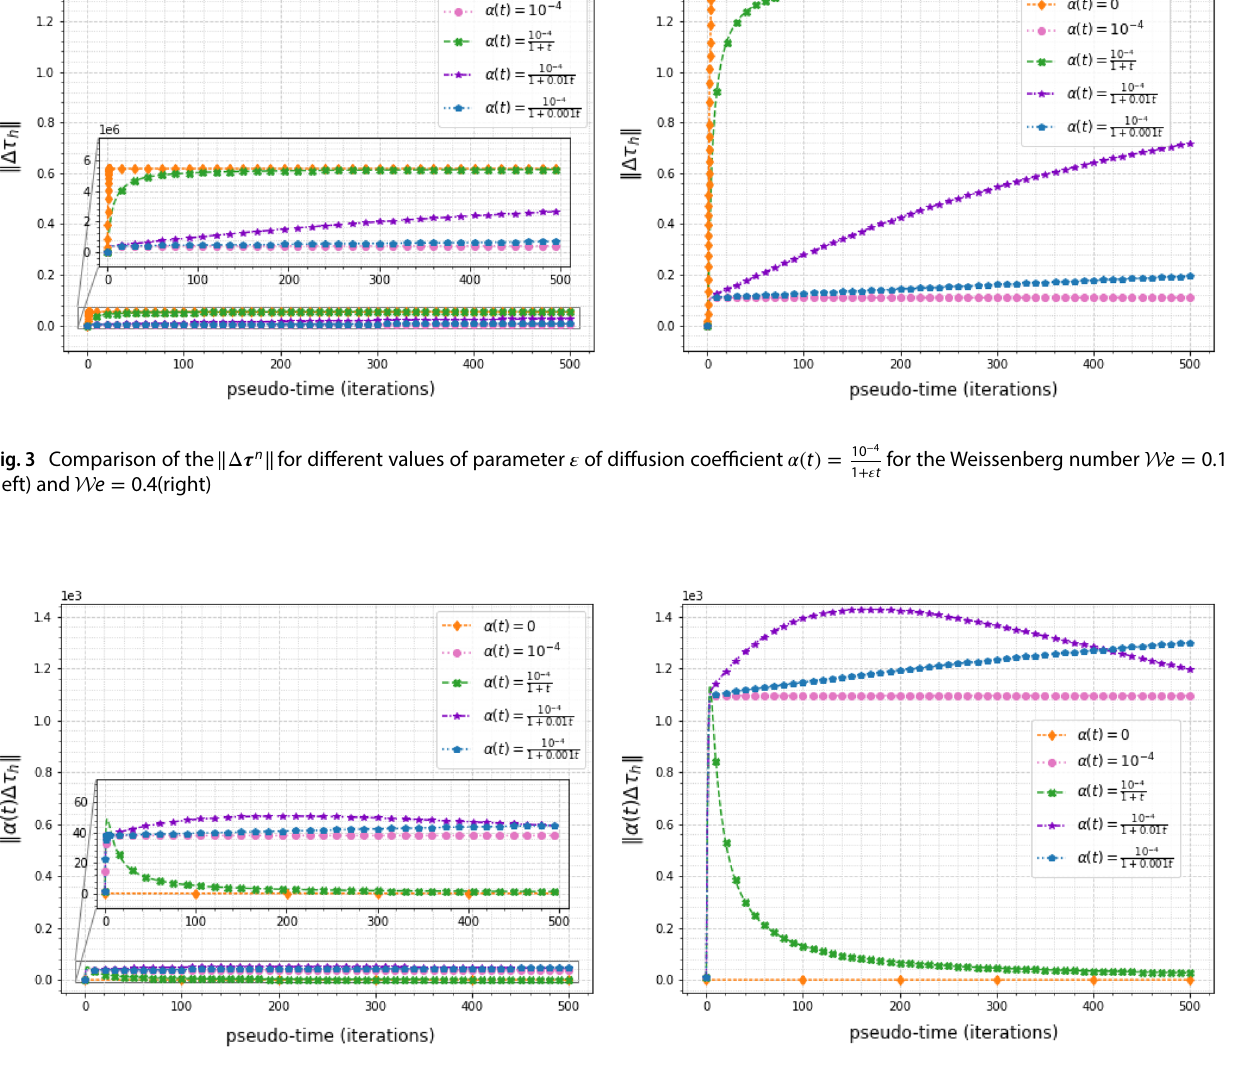
Fig. 4 Comparison of the (left) and W e = 0.4